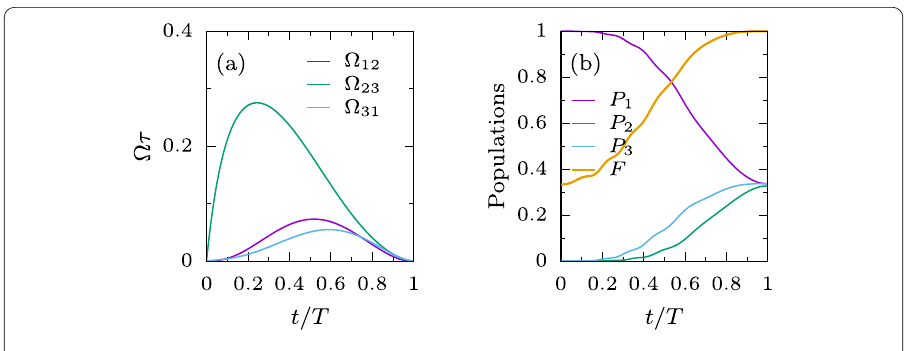
( | 1 (cid:2) – i | 2 (cid:2) – | 3 (cid:2) ) in the 3L 3